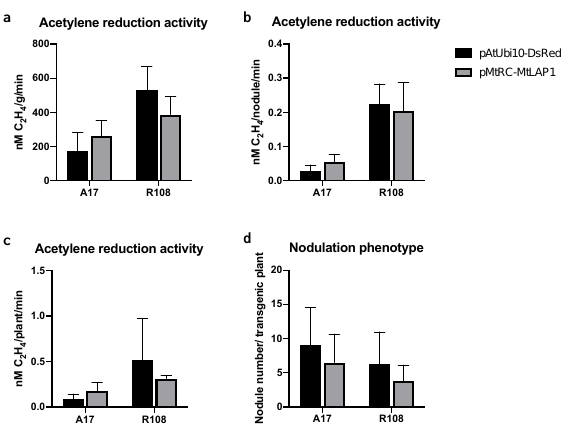
Figure 4. The MtLAP1 screening marker does not affect the acetylene reduction activity or nodule number of M. truncatula compared to DsRed. ( a – c ) Acetylene reduction activities 21 days after inoculation with S. meliloti 2011 presented on a per gram of nodule ( a ), per nodule ( b ) and per transgenic plant ( c ) basis; ( d ) Nodule numbers for plants transformed with